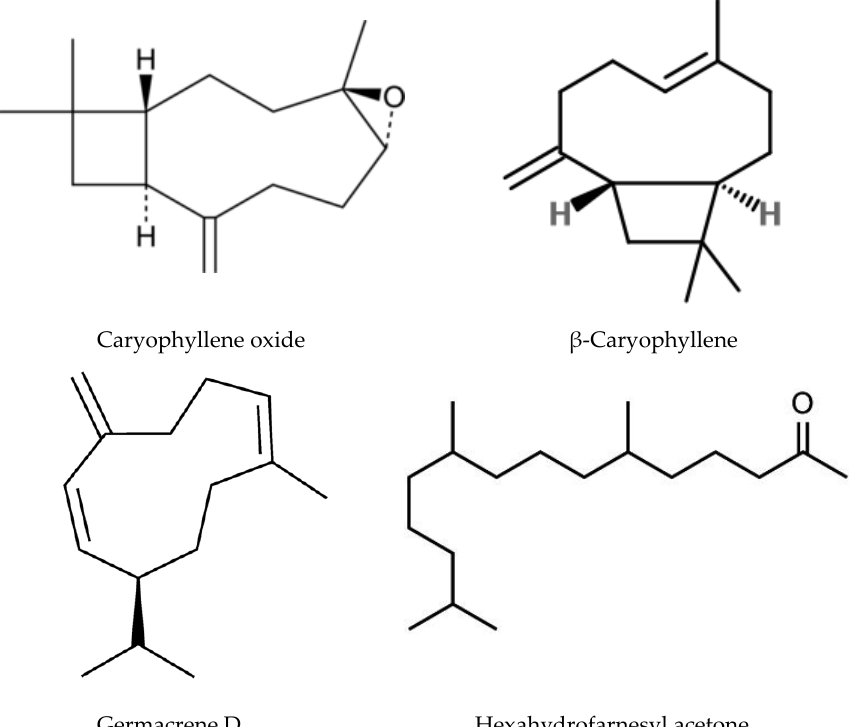
Figure 3. Compounds of the Ailanthus altissima essential oil.